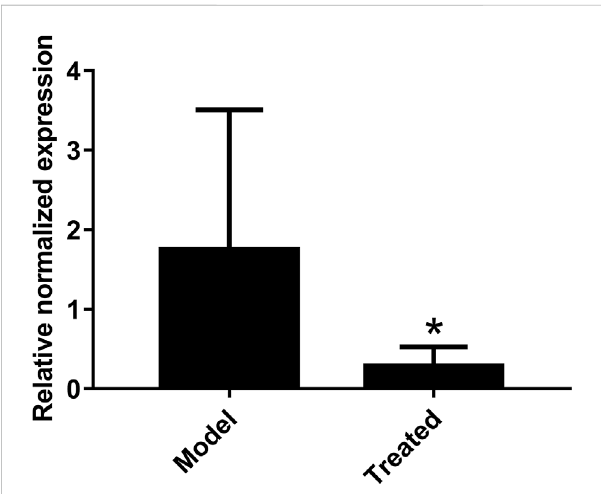
FIGURE 8 Effect of HJ on the viral load of PEDV in the ileum of piglets. The presence of PEDV in ileum were examined with real-time PCR using speci fi c primers. The expression levels of mRNA were calculated in relation to the expression level of GAPDH. Data are represented as mean ± SD, n = 7. *, and p < 0.05 was considered statistically signi fi cant compared with the model